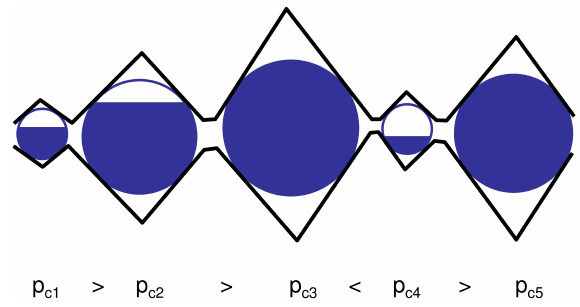
Figure 5. Illustration of the influence of the capillary pressure distribution p by the size of the circles in the pores) on the temporal average liquid water saturation (represented by the filling levels of the